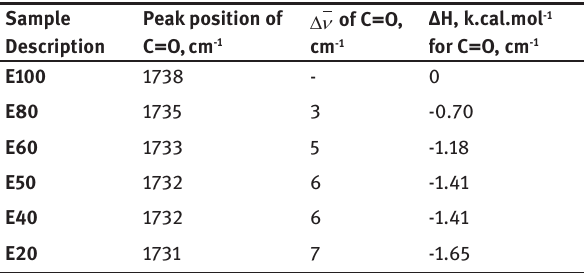
Table 1: Shift and Enthalpy of Interaction of Carbonyl Peak of EMA in the